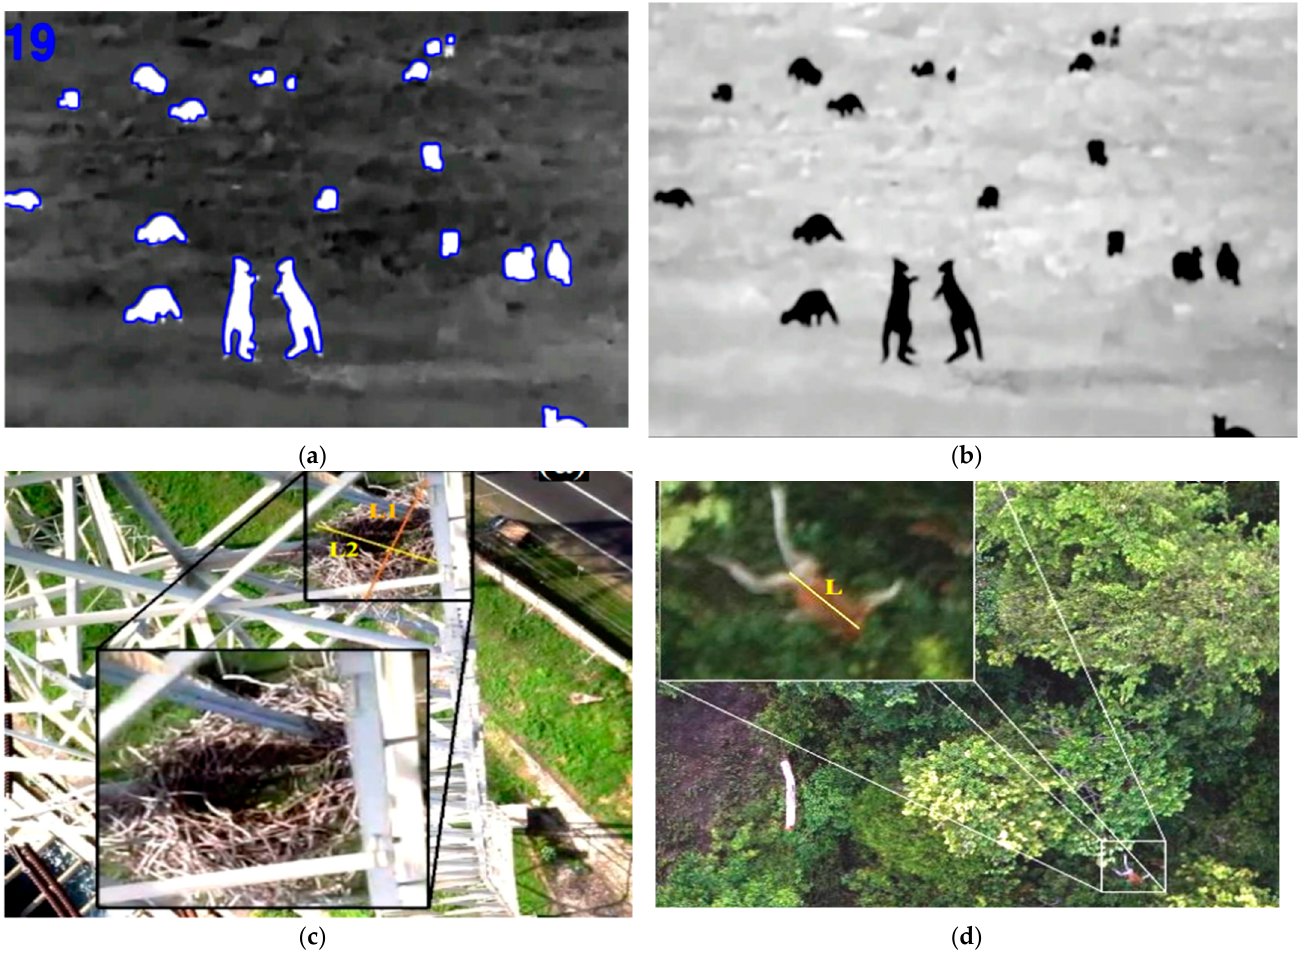
Figure 10. Identification result of wildlife. ( a ) Result footage for kangaroos (Figure from [22]), ( b ) Image inverted (Figure from [22]), ( c ) White-bellied Sea Eagles (Figure from [132]), ( d ) Proboscis Monkey (Figure from [132]).